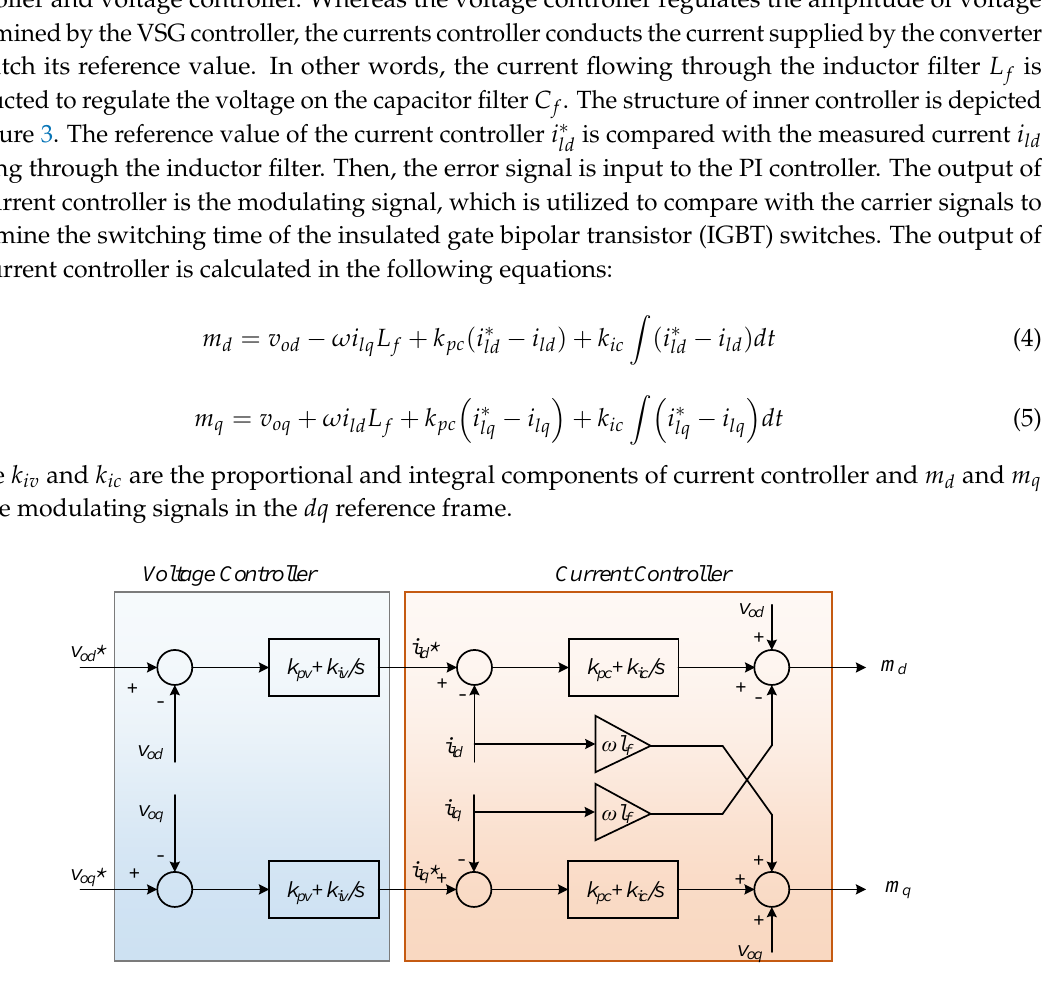
Figure 2. Control scheme of the virtual synchronous generator control–based grid-forming converter.